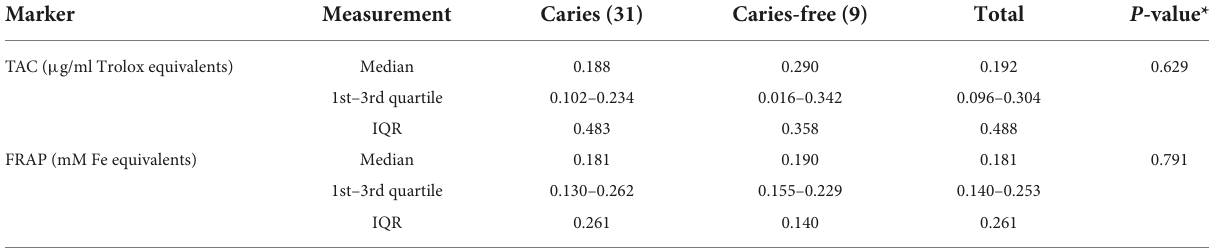
TABLE 1 Antioxidant capacity of saliva supernatant measured by TAC and FRAP decolorization assays.